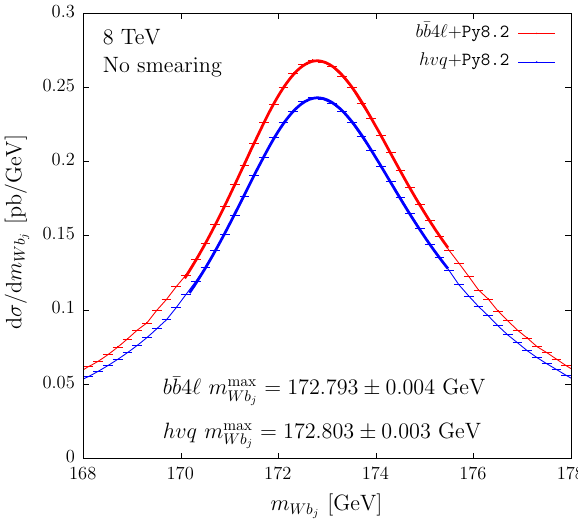
Fig. 9 Smeared d σ/ dm Wb distribution obtained with the b ¯ b 4 (cid:4) and j t ¯ tdec generators interfaced with Pythia8.2 , for m t = 172 . 5 GeV